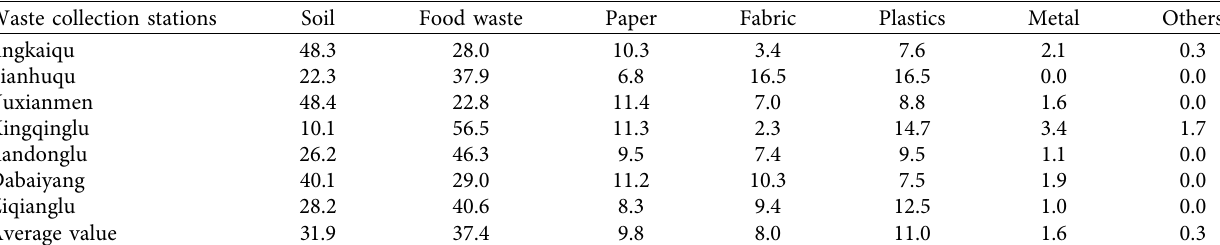
Table 2: Mass percentages of MSW compositions in Xi’an (%).